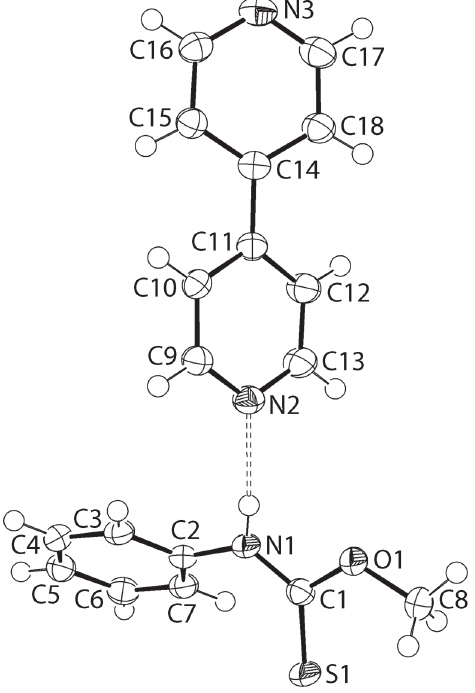
Table 1: Data collection and